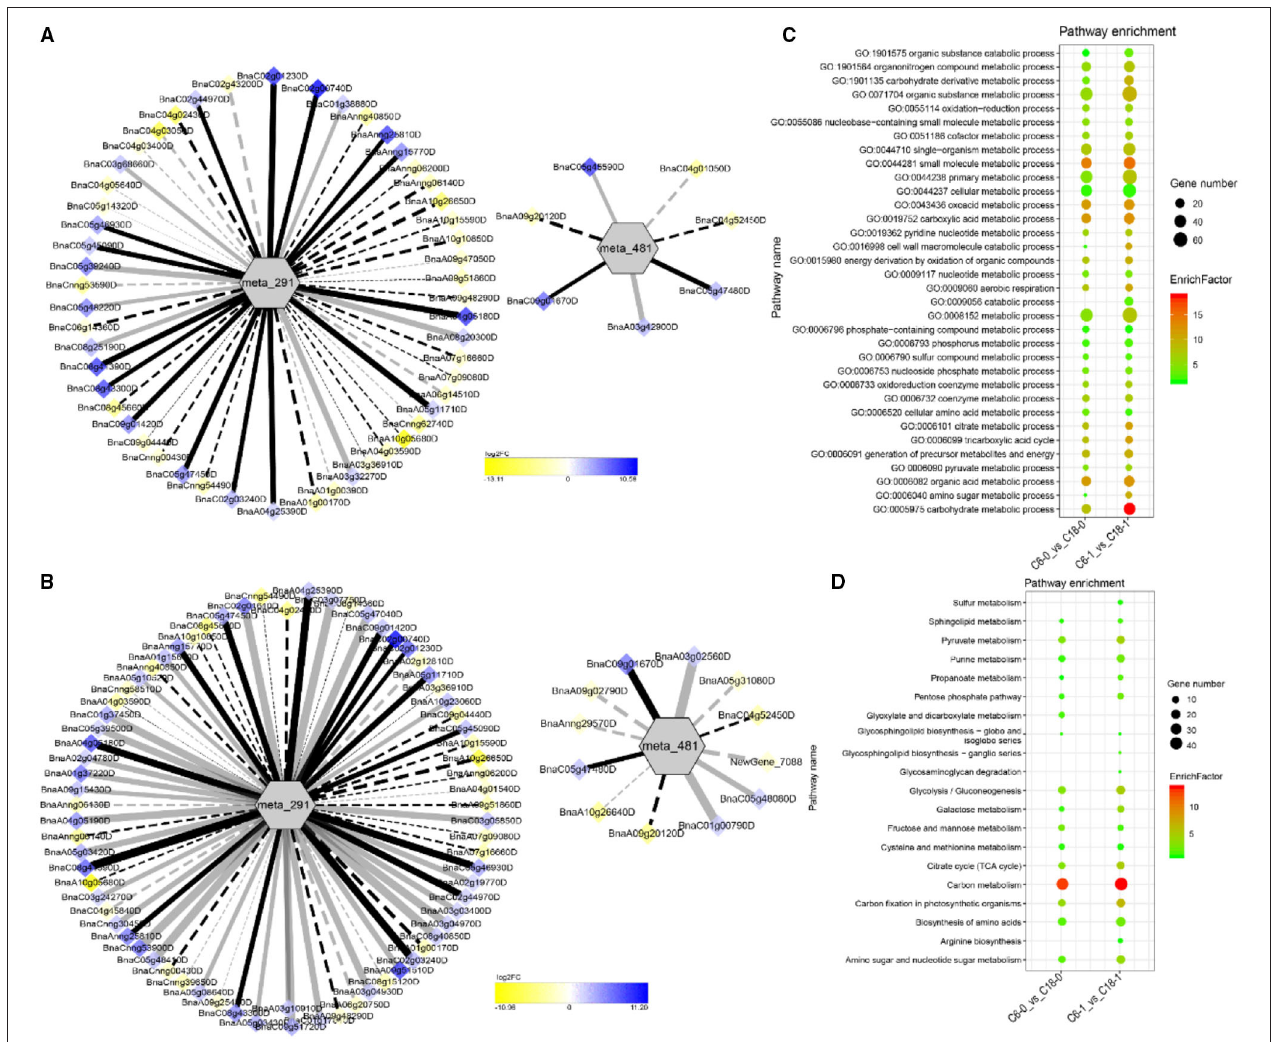
FIGURE 7 | Correlation network analysis between DAMs and regulatory genes related to CS. (A) Analysis of C6-0 vs. C18-0 and (B) analysis of C6-1 vs. C18-1. Log 2 FC of genes, in response to CS, are indicated in heatmap colors ranging from yellow (downregulated) to blue (upregulated); log 2 FC values are indicated in the legend; the width of the connecting lines indicating the strength of the correlation; solid lines indicating the positive correlation and dashed lines indicating the negative correlation; black lines indicating the common genes and gray lines indicating the specific genes accumulated at that time point. (C,D) Scatter plots for the GO-BP enrichment analysis and KEGG pathway enrichment analysis of DEGs from G3, respectively. Only the highly enriched and most relevant terms and pathways are shown in the plots ( Q < 0.05.) –log 10 ( Q ) for enrichment